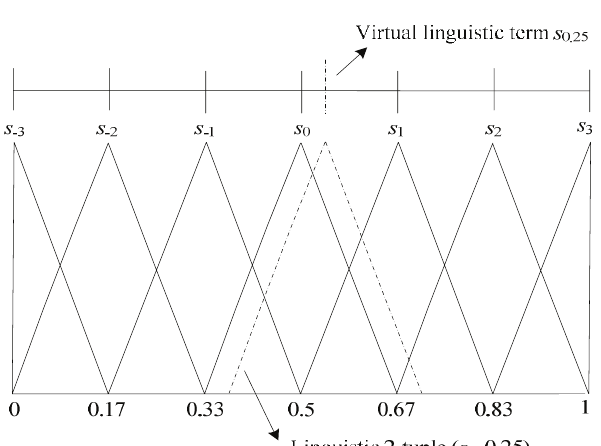
Fig. 2 Example of the virtual linguistic terms and linguistic 2- tuple.